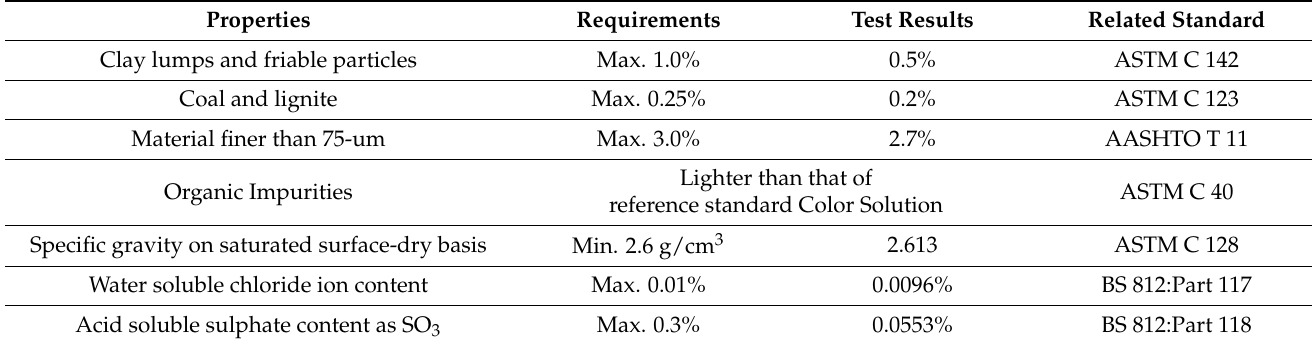
Table 4. Properties, requirements and test results for fine aggregates [36–42].